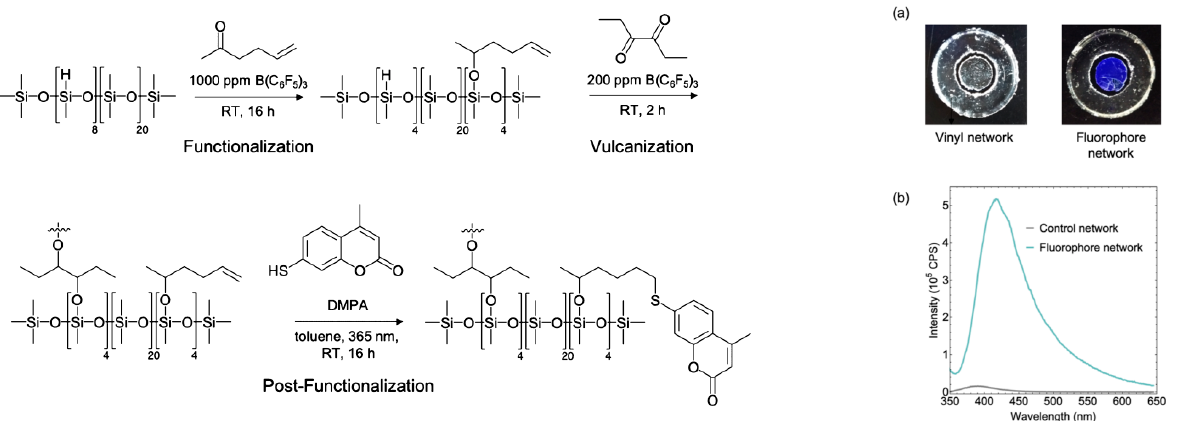
Figure 31. A scheme for synthesizing a cross-linked silicone by hydrosilylation involving a diketone followed by hydrothiolation with a thiol-containing coumarin dye. Reproduced with permission from Ref. [130]. Copyright 2019 American Chemical Society. ( a ) Images of the vinyl-functionalized network before (left) and after (right) thiol − ene click with 7-mercapto-4- ethylcoumarin under 365 nm irradia- tion. Center disk has undergone thiol − ene click, while the outer ring is an unreacted control sample. ( b ) Fluorescence spectra of the coumarin-containing network as well as the undecorated